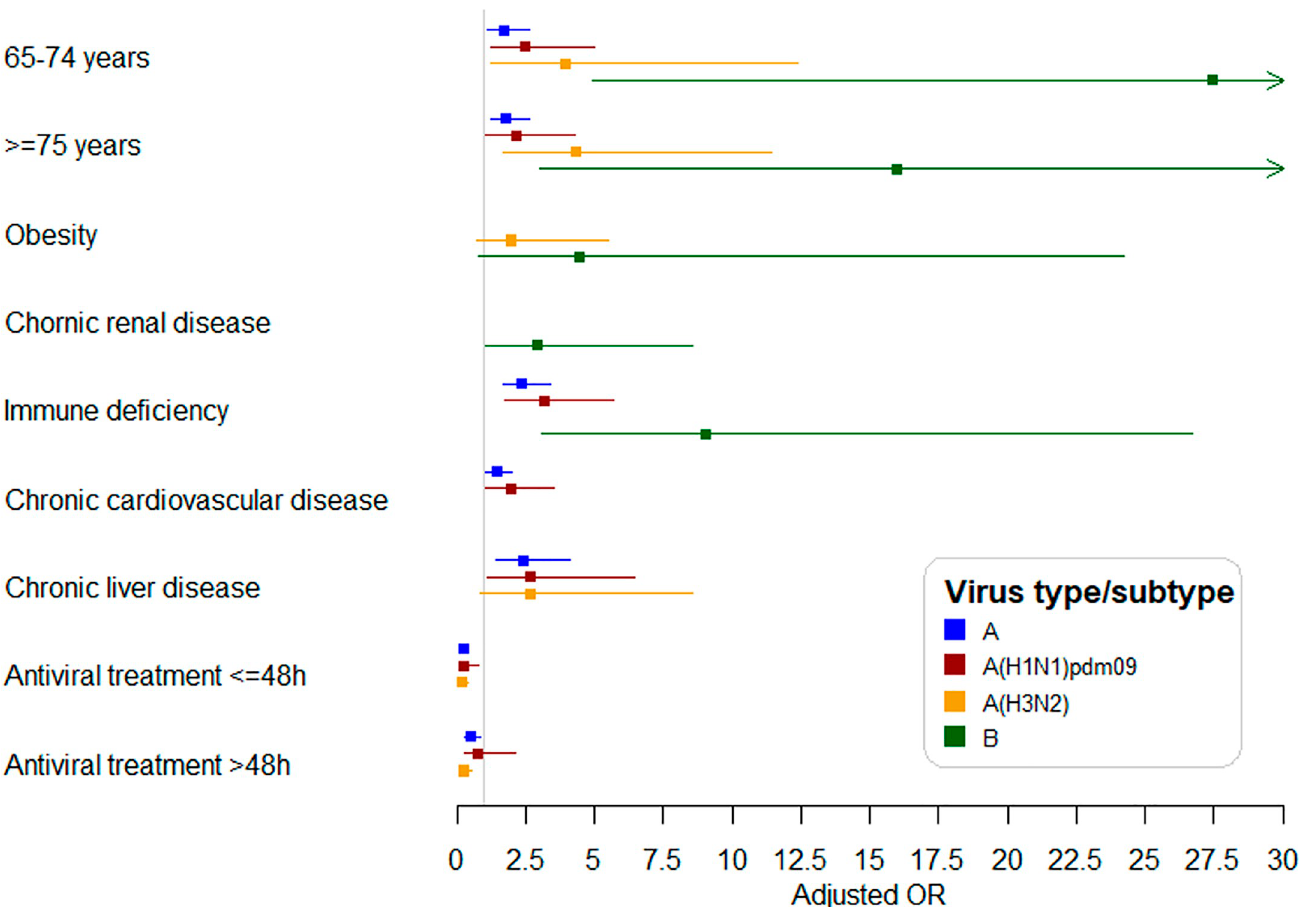
Fig 2. Factors associated with death in hospitalized patients according to influenza type and subtype.